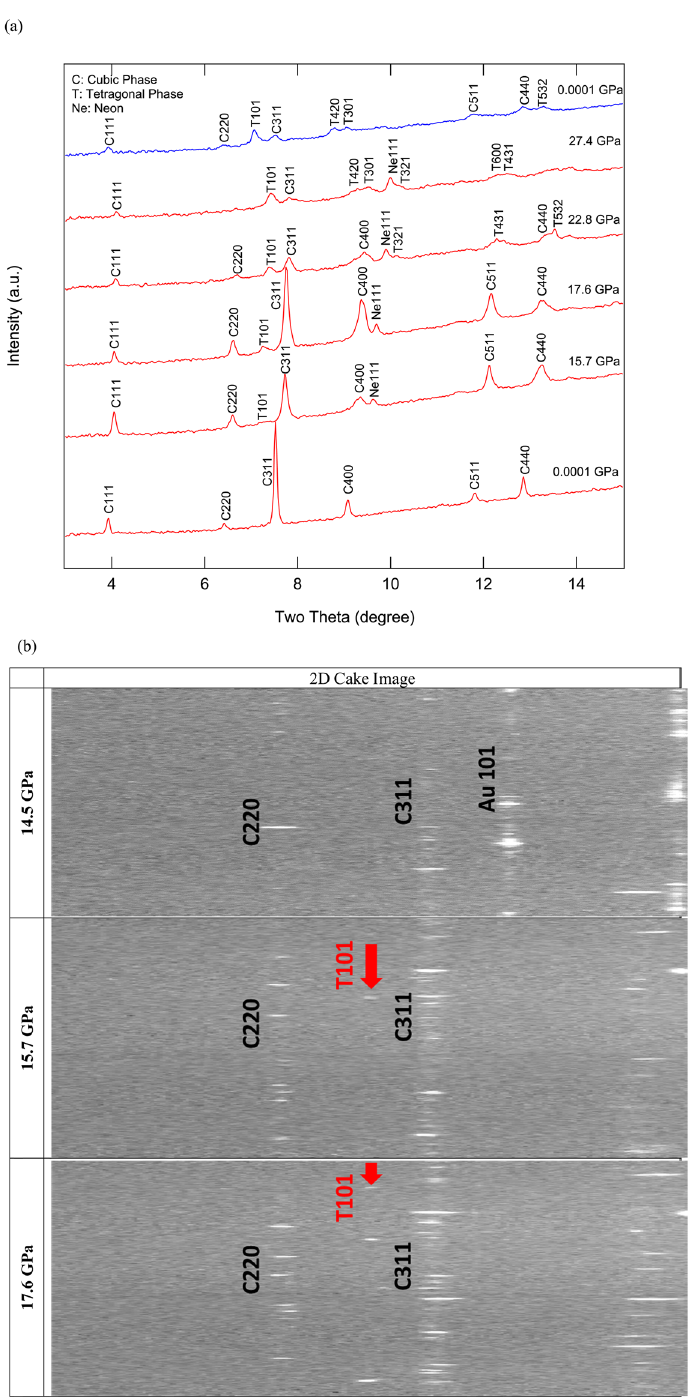
Figure 4. ( a ) Representative X-ray diffraction patterns of Mg 2 TiO 4 collected in Run 1. A new peak 101 belongs to the high-pressure phase that coexisted with spinel from 15.7 to 27.4 GPa, and is also present in the decompressed pattern. Red; compression patterns, blue: decompression pattern. ( b ) 2D cake images show the new peak T101 observed above 15.7